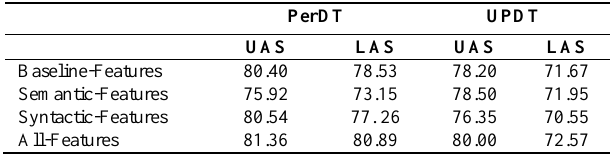
Table 3. Projective-First-Order.